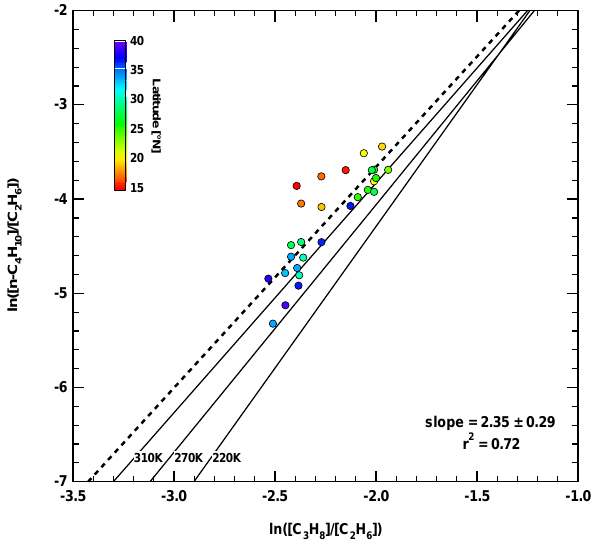
Fig. 7. Correlation of the natural logarithms of n-butane/ethane and propane/ethane from all samples collected in monsoon outflow dur- ing July and August. Points are color-coded by sampling location latitude. The dashed line represents the linear fit to the data, while the solid lines represent, relationships predicted for purely chem- ical loss by reaction with OH at 310K, 270K and 220K (slopes from 2.44 to 3.01). The uncertainty of the slope denotes the 95% confidence interval.